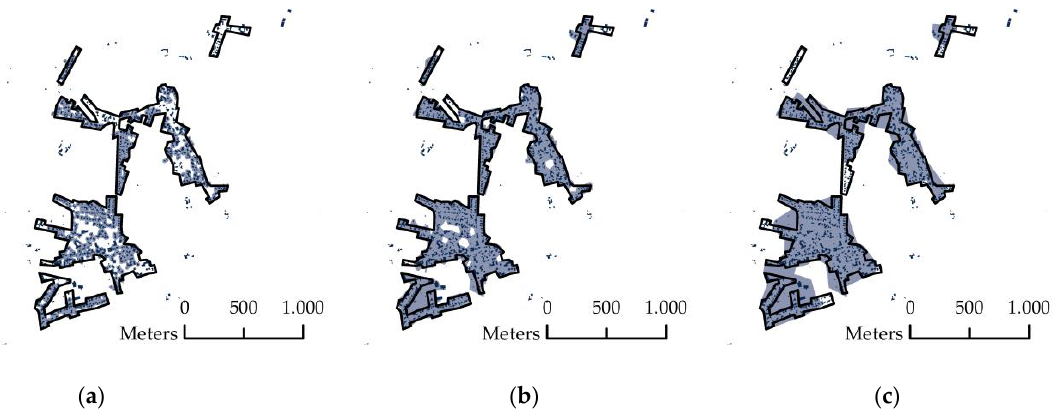
Figure 3. Examples of different aggregation levels by using different parameter combinations (P 1 and P 2 ). Automatic delineation (blue areas) in comparison to a reference geometry (black lines) (Official building polygons, ATKIS ® Base-DLM© Geobasis-DE/BKG (2011)): ( a ) P 1 10/P 2 10; ( b ) P 1 40/P 2 40; and ( c ) P 1 70/P 2 100.